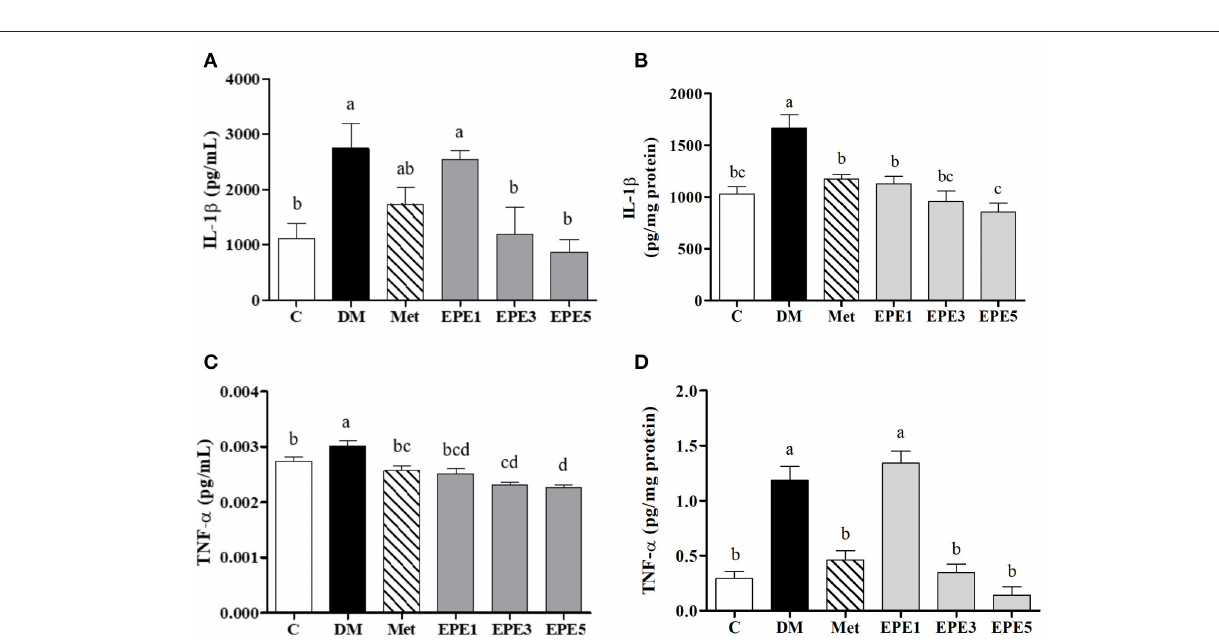
FIGURE 6 | The levels of (A) plasma interleukin (IL)-1 β , (B) testis IL-1 β , (C) plasma tumor necrosis factor (TNF)- α , and (D) testis TNF- α in diabetic rats after 4 weeks of treatments. Data are shown as the mean ± SEM ( n = 6). The values with different superscript letters (a–d) represent significantly differences ( p < 0.05) as analyzed by Duncan’s multiple range test. C, control; DM, diabetes mellitus; Met, metformin; EPE, Echinacea purpurea ethanol